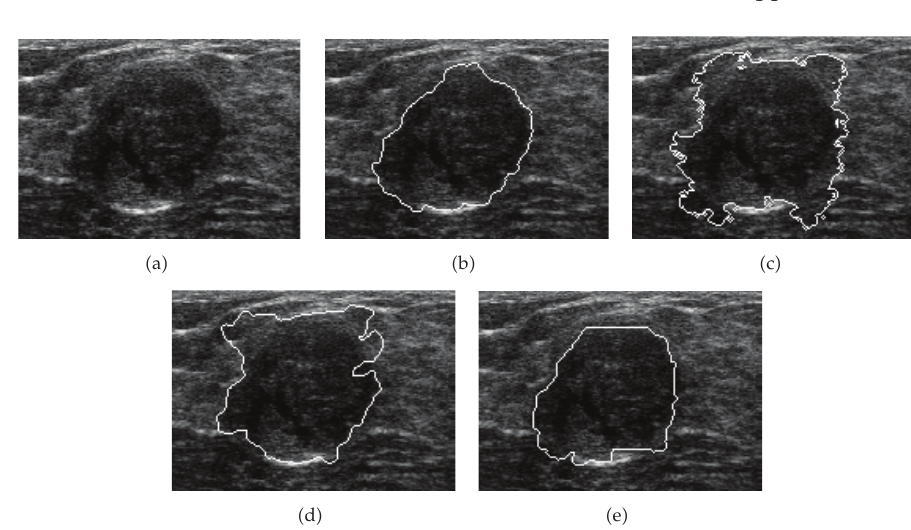
Figure 9: Segmentation of a benign breast tumor having low contrast and weak boundaries. (cid:3) a (cid:4) Original image. (cid:3) b (cid:4) Golden standard. Segmentation results of (cid:3) c (cid:4) GAC (cid:5) 11 (cid:6) , (cid:3) d (cid:4) DRLSE (cid:5) 16 (cid:6) , and (cid:3) e (cid:4) the proposed PGBLSE models.